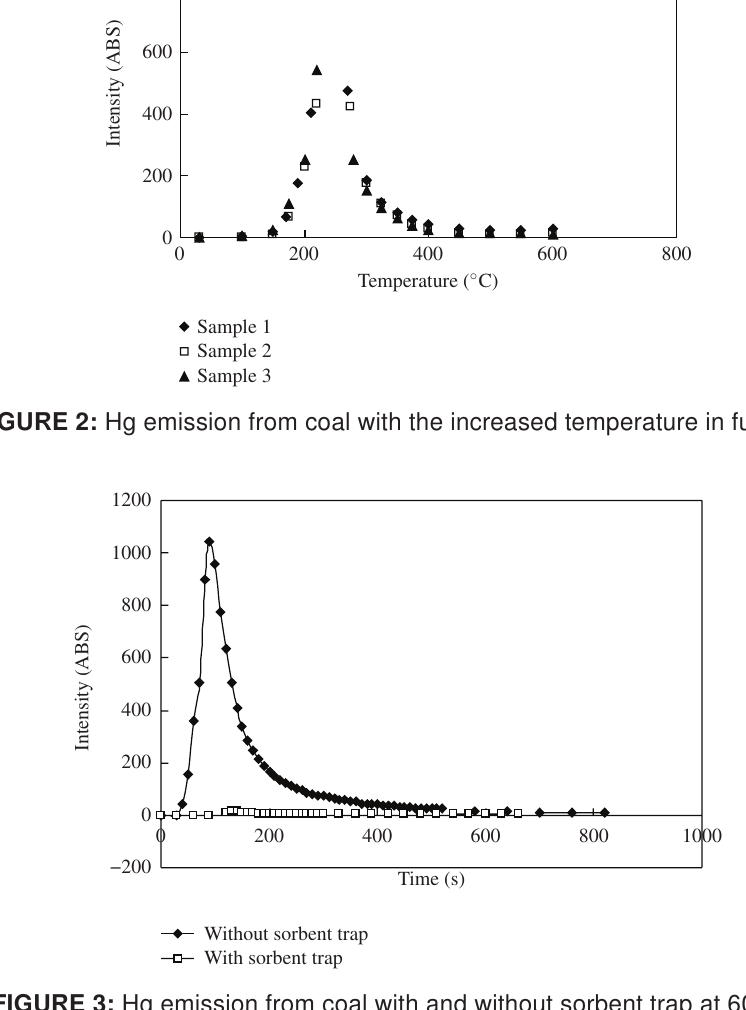
FIGURE 3: Hg emission from coal with and without sorbent trap at 600 ◦